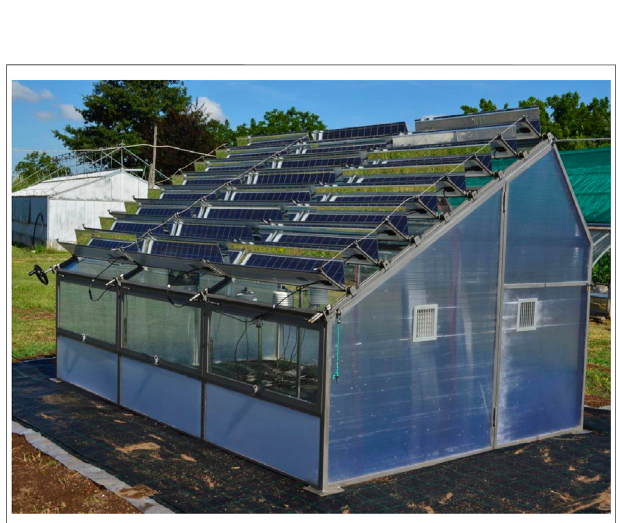
FIGURE2| Prototypegreenhousestructure fi ttedwithPVpanels(Ifeanyi et al., 2021).